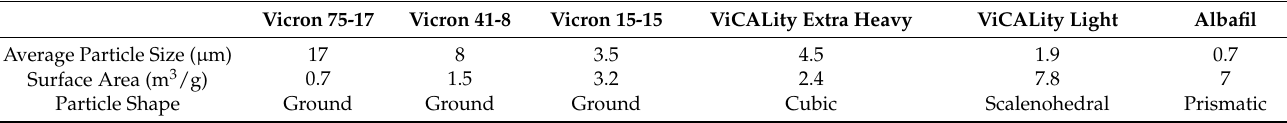
Table 1. CaCO 3 grade specifications per Specialty